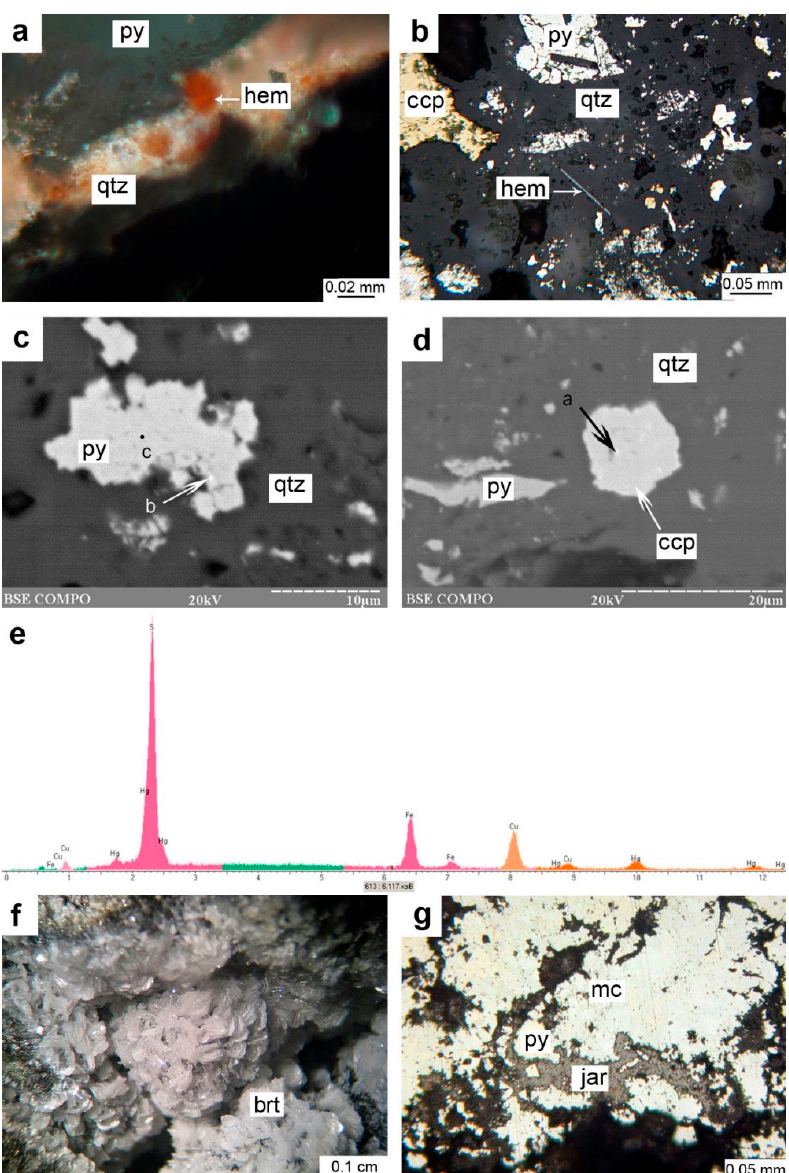
Figure 7. Accessory minerals of sulfide breccias from the Semenov ‐ 3 hydrothermal field: ( a ) hematite globule within the quartz rim around authigenic pyrite; ( b ) specular hematite crystal in the breccia cement; ( c ) inclusion of HgS phase (point b) in crystalline pyrite aggregate; ( d ) inclusion of HgS phase (point a) in chalcopyrite grain; ( e ) EDS spectrum of a mixture of chalcopyrite and HgS phase; ( f ) barite druse in the cavity of sulfide breccia; ( g ) jarosite (jar) replacing marcasite–pyrite aggregate from the rim. figure a, b, g, reflected light; figure c, d, back ‐ scattered electron images; figure f, binocular microscope.